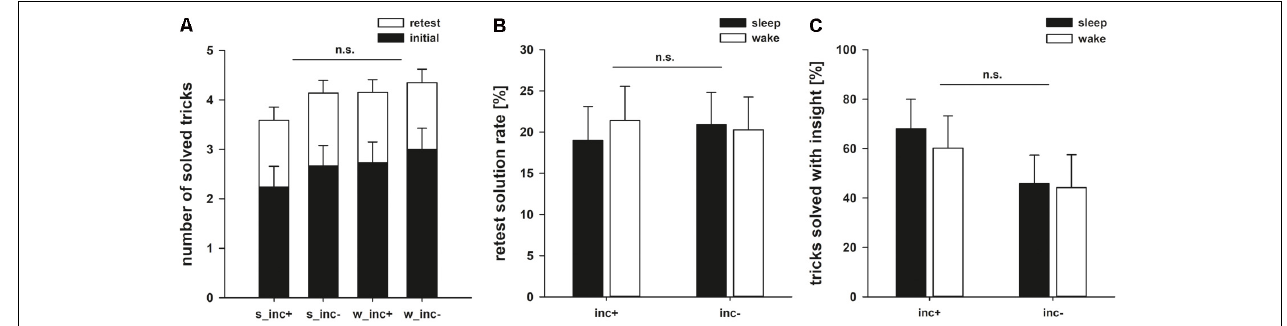
FIGURE 3 | (A) Number of solved tricks after the initial and retest phase. (B) Retest performance rates for the magic tricks for groups with incubation (inc+) and without incubation (inc–). (C) Percentages of solved tricks that were solved with insight instead of analytical step-by-step problem solving. Here, we observe a numerical difference between the experimental and control groups, with incubation increasing the number of tricks solved with insight. TABLE 2 | Performance in the initial and retest phase on the magic tricks. Group (n) Net performance increase